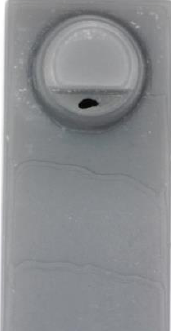
Figure 6. Printing defect observed in all 0° samples at the same position on the build platform.